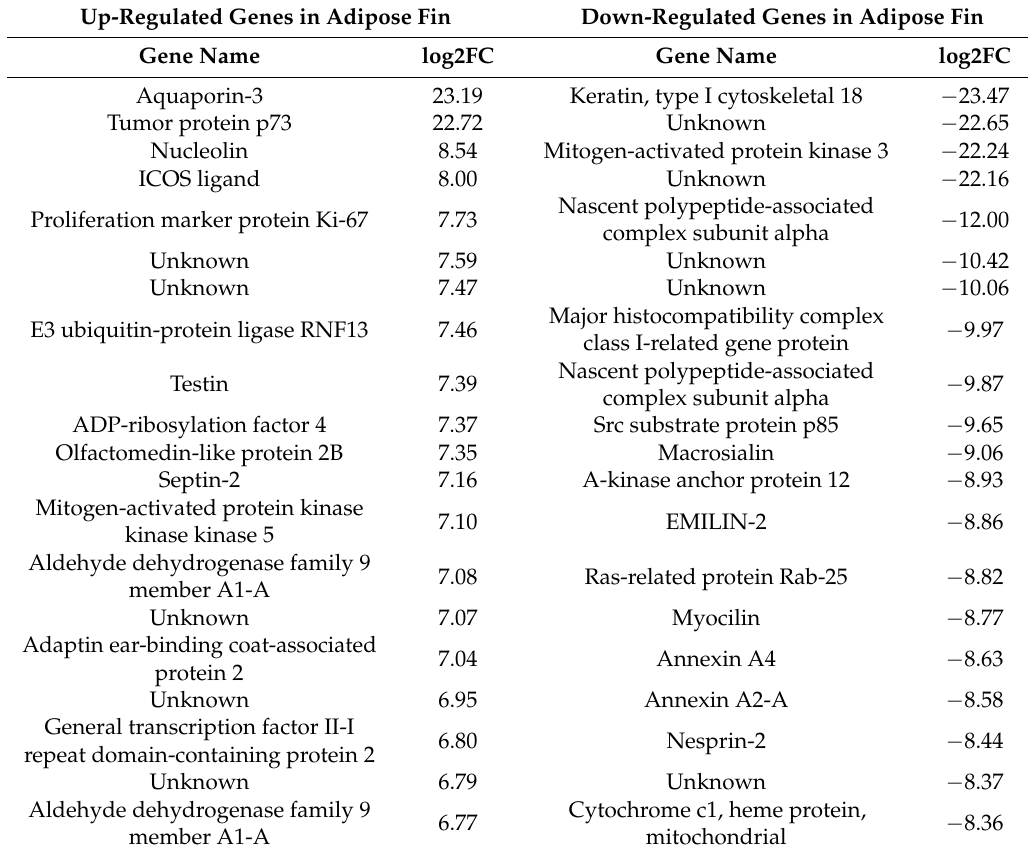
Figure 1. Differentially expressed genes (DEGs) were identified by comparing the HT and NT groups. A total of 2893 DEGs and 836 DEGs in gill and adipose fin were identified, including 630 up-regulated and 2263 down-regulated DEGs in the gills and 289 up-regulated and 547 down-regulated DEGs in the adipose fins. Table 3. Top 20 up- and down-regulated DEGs in adipose fin